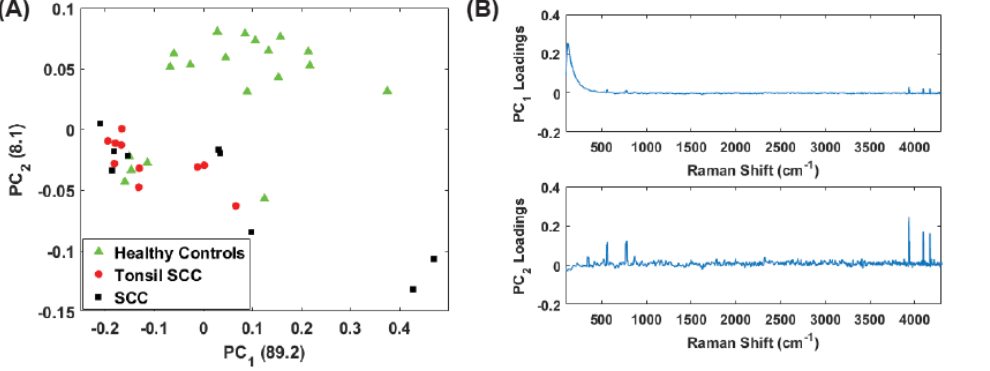
Figure 7. ( A ) Plot of the first two principal component (PC) scores for only the unstained tissue samples. The analysis was performed on the full spectral data, and show good separation between healthy and diseased tissue. The numbers in parentheses represent the information content associated with each principal component. ( B ) Corresponding loadings plots for the PCs shown in ( A